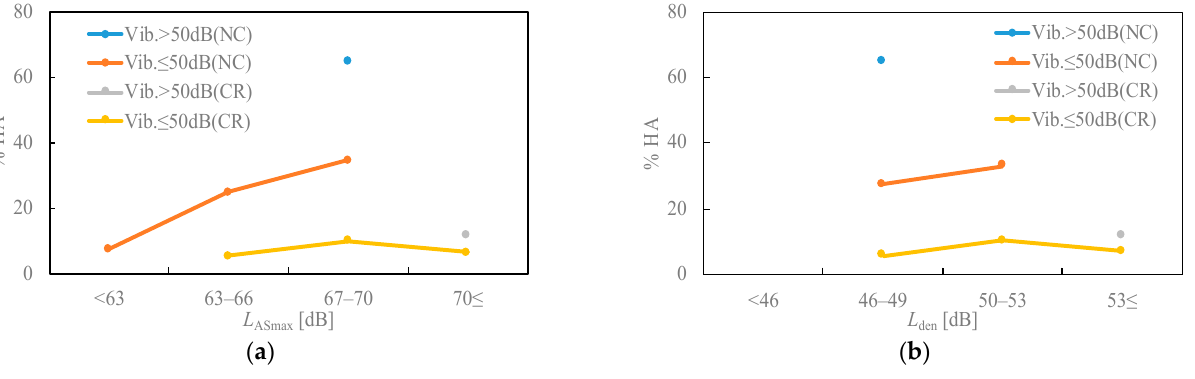
Figure 3. Relationships between noise exposure level and HA. ( a ) L ASmax ; ( b ) L den .